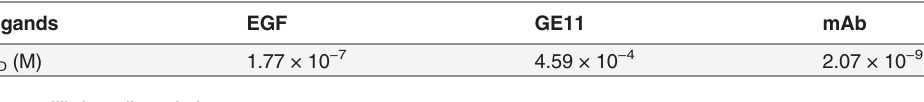
Table 1. KD of ligands to EGFR based on Fig.